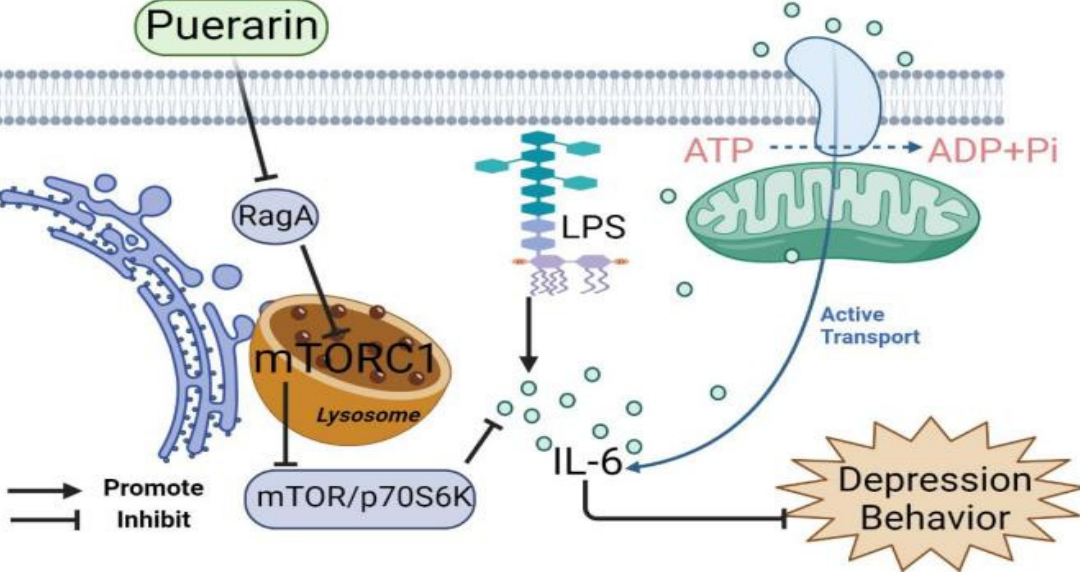
Figure 3. Mechanism of puerarin inhibiting the expression of pro-inflammatory cytokine IL-6